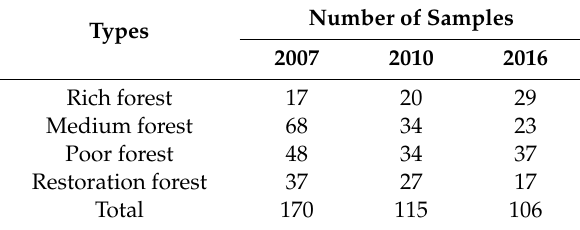
Table 2. Ground data for the four forest types in the study area in 2007, 2010, and 2016.